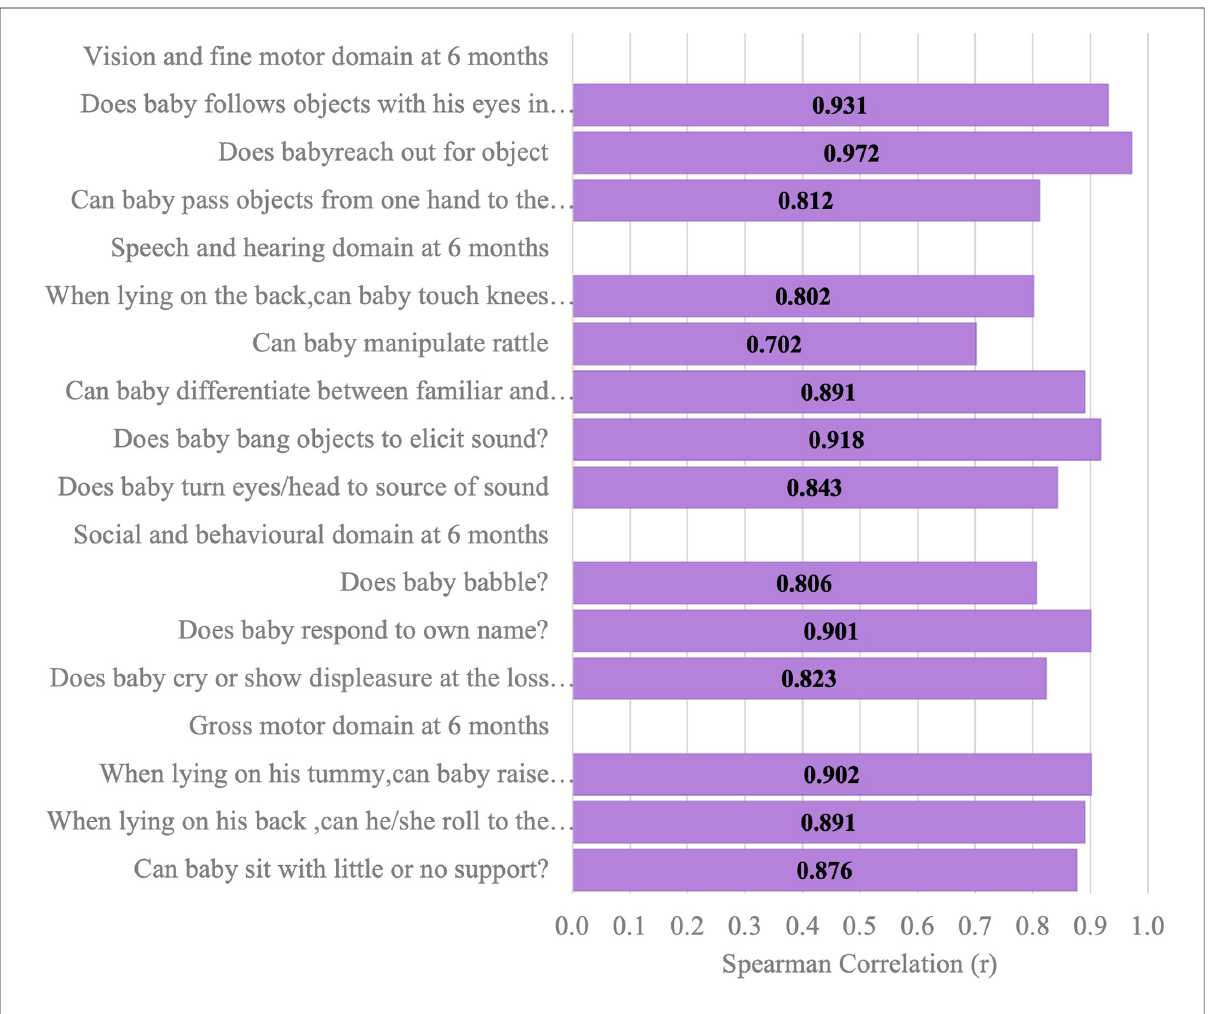
FIGURE 9 Spearman correlation coef fi cient of the ISDS scores of two assessors of the same participants aged 6